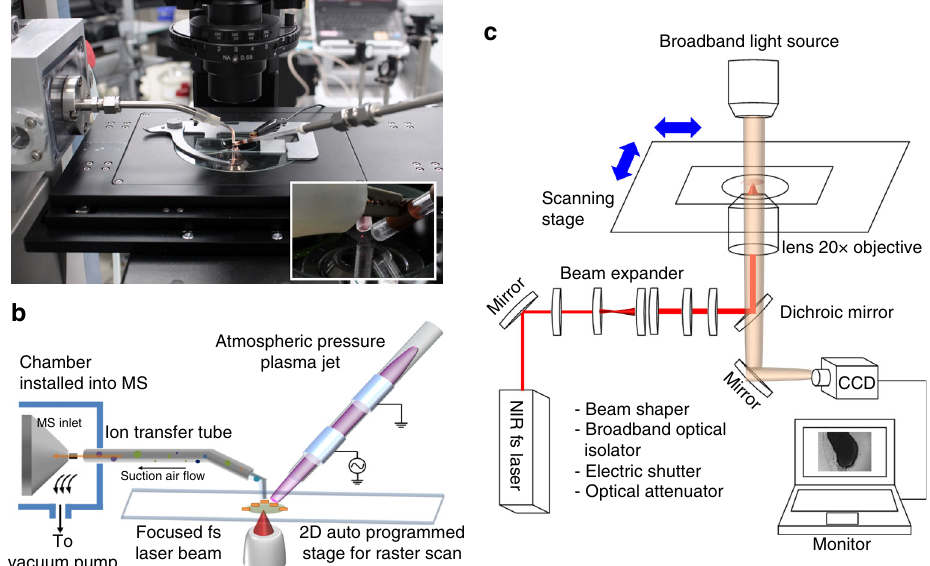
Fig. 1 AP-nanoPALDI mass spectrometric system with a combination of fs laser oscillator, atmospheric pressure (AP) plasma jet, and air fl ow-assisted ion transfer equipment. a Picture of analysis stage in proposed AP-nanoPALDI MS system. b Schematics of AP desorption and ionization procedure on stage and ion transport. c Different light paths between visible and near infrared (NIR) spectra using dichroic mirror. This feature allows the NIR laser light to be re fl ected towards the target while the visible light passed through freely. Therefore it allows optical imaging monitoring and desorption by laser beam of